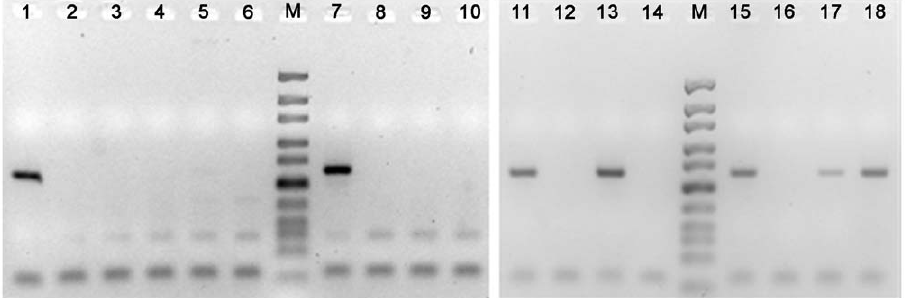
Figure 2. Expression analysis of miR-517a by RT-PCR. PCR reactions were performed and then analyzed in 4% small DNA Agarose. The expected DNA-fragment has a size of 62 bp, Ultra low range Ladder (Fermentas) was used as Marker (M). Lane 1: S40.2, 2: S40.2 without reverse transcriptase (–RT), 3: S121, 4: S121–RT, 5: thyroid (normal), 6: thyroid–RT, 7: placenta, 8: placenta-RT, 9: S270.2, 10: S270.2–RT, 11: S290.1, 12: S290.1– RT, 13: S141.2, 14: S325, 15: S211, 16: S211–RT, 17: fetal RNA, 18: adult testis, 19: fetal RNA-RT, 20: S141.2-RT, 21: adult testis-RT, 22: S325-RT (for details of the cell lines and tumor samples see Table 1). doi:10.1371/journal.pone.0009485.g002 PLoS ONE |